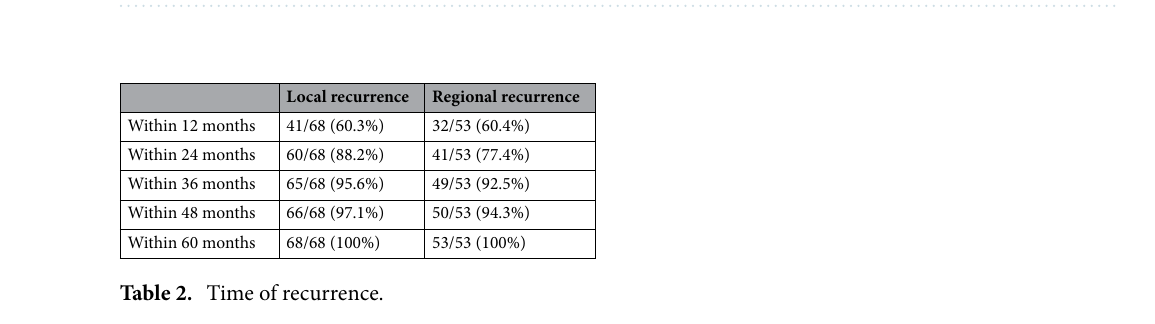
Table 1. Patient demographics and clinical characteristics. SD: standard deviation; IQR: interquartile range; IHC: immunohistochemistry; n/a: not available; RT: Radiotherapy. ANOVA normally distributed variables. Kruskal–Wallis test for non-normally distributed continuous variables. Chi-square test for nominal variable. Log-rank test for time-dependent variable (local and regional recurrence).